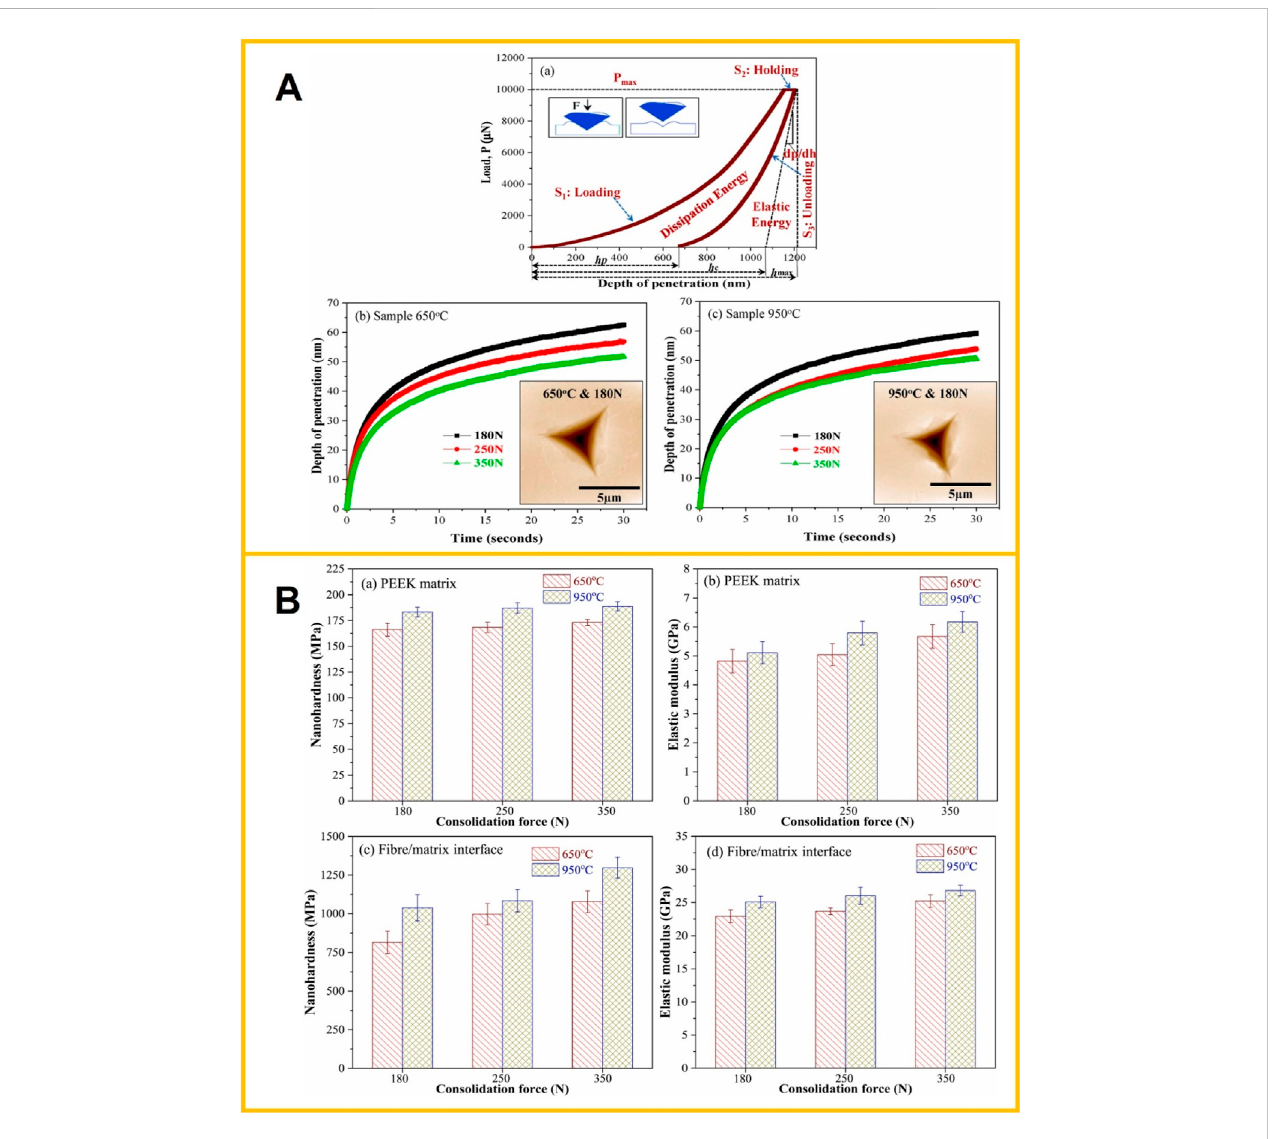
FIGURE 8 (A) (a)Loadvs.displacementcurveandcreepperformanceofCF-PEEKcompositesinpolymermatrixmanufactured atdifferenttemperatures;(b)650 ° C and (c) 950 ° C. Reprinted with permission from (Gain et al., 2022). Copyright 2022 Elsevier Ltd. (B) Nanohardness and elastic modulus as a function of consolidation force of CF-PEEK composites; (a, b) in polymer matrix and (c, d) fi bre/matrix interface. Reprinted with permission from (Gain et al.,